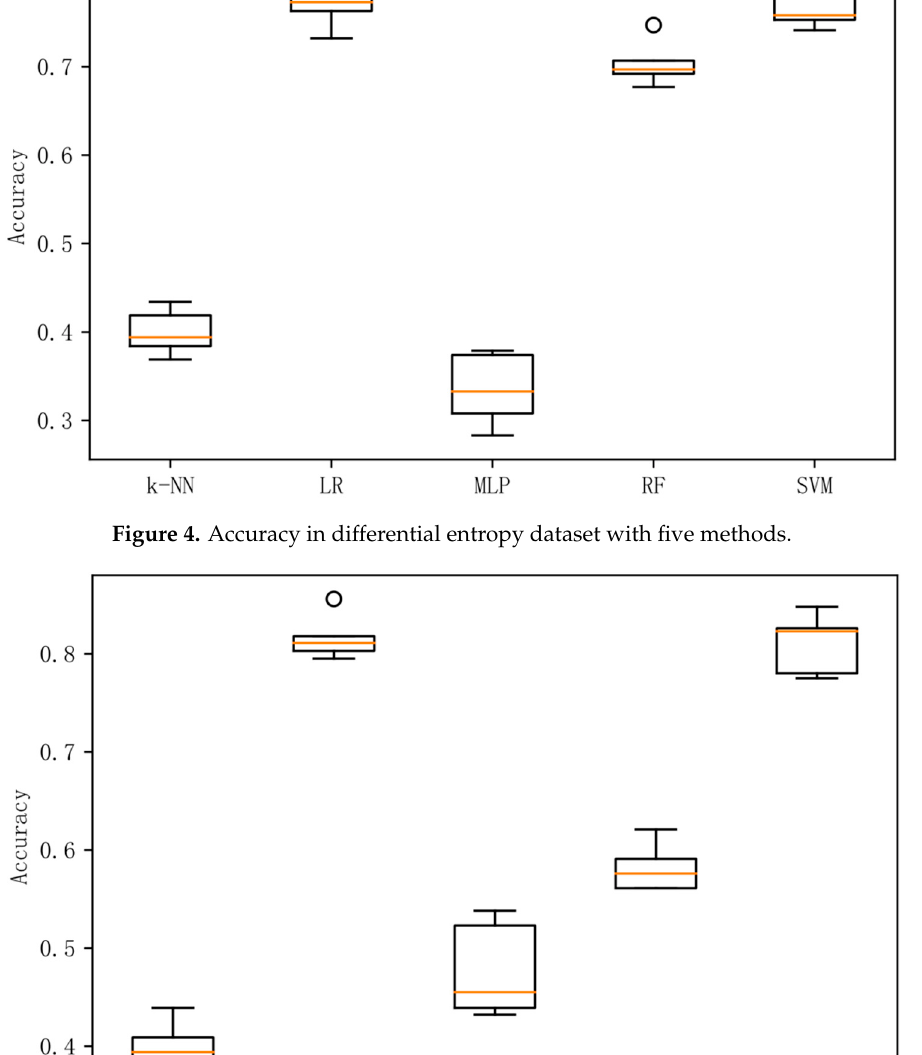
Figure 3. Accuracy in original dataset based on LDA with five methods.